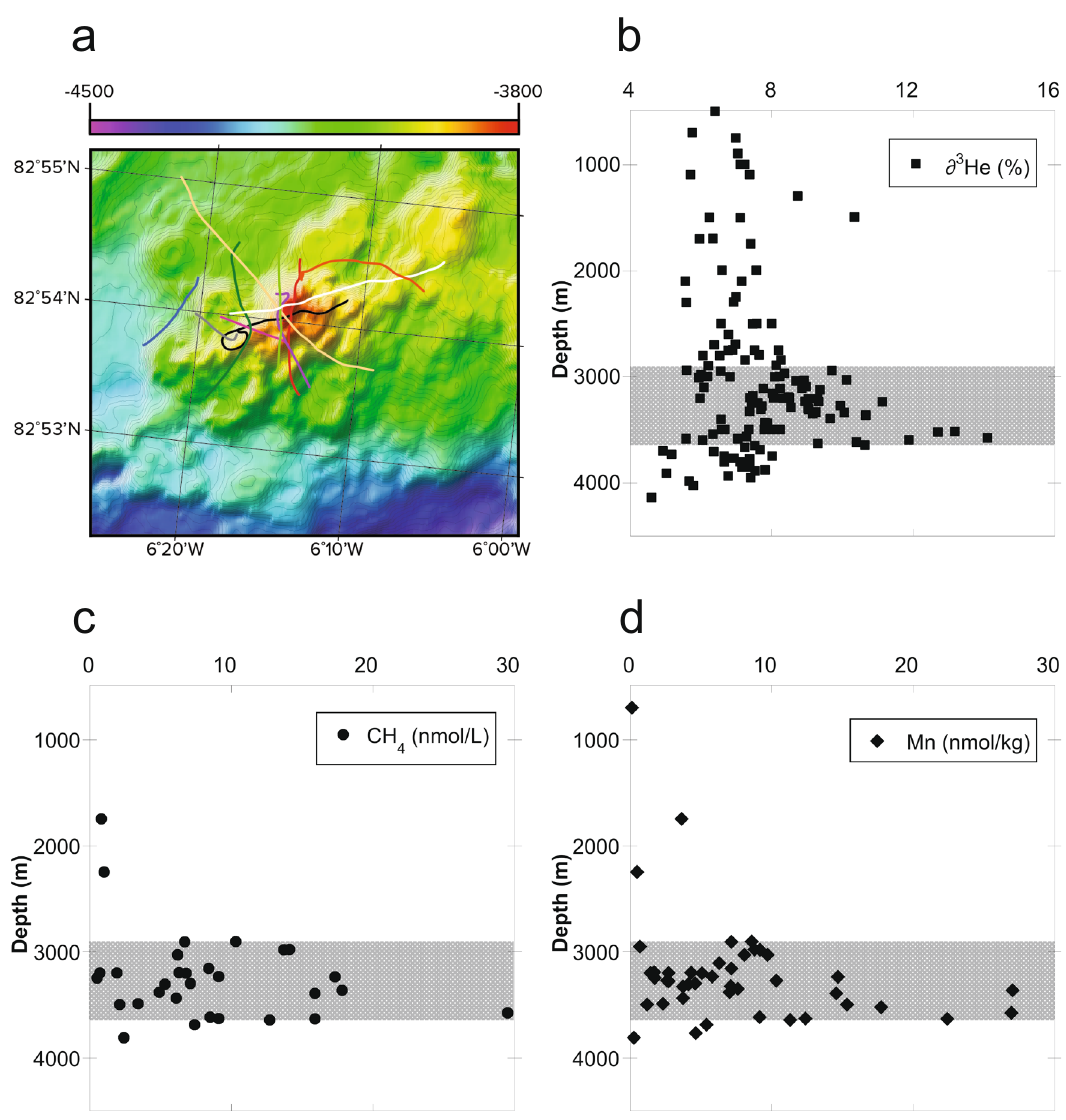
Fig.3|PlotsofAurorahydrothermalplumecomposition.a Locationmapforthe trajectories of 11 CTD deployments over the Aurora mound, completed in 2014 6 projected over multibeam data from 2019 16 that is gridded at 20m. Each CTD deployment was selected based on interpretation and prediction of ice- fl oe tra- jectories thatdictated the direction of travel. Cumulative depth pro fi les are shown